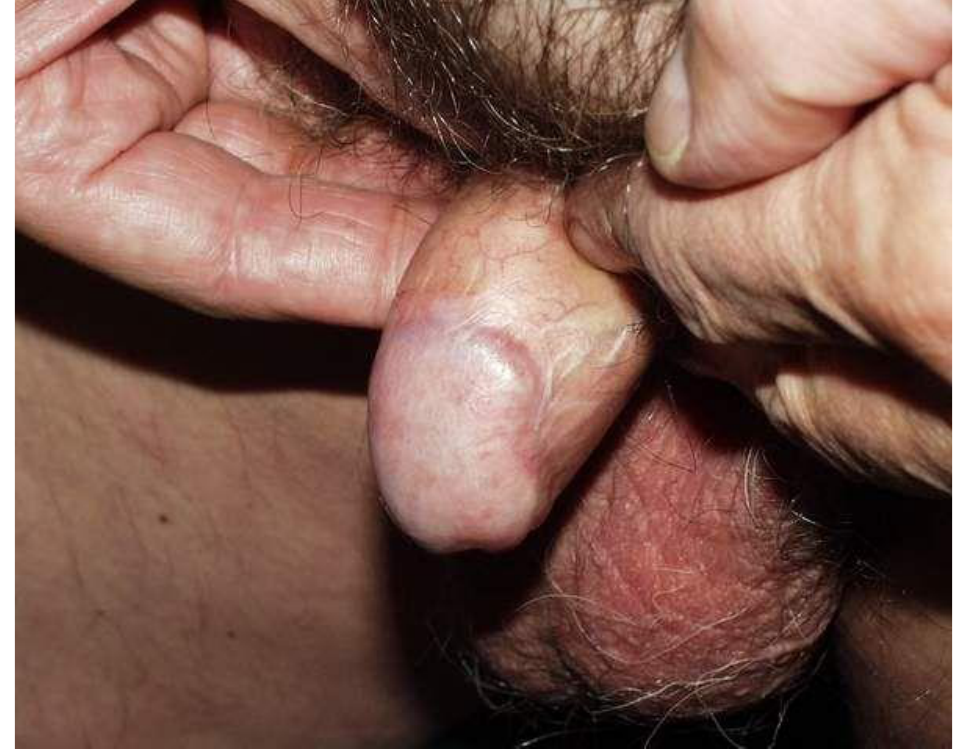
Figure 5. Result at 5 years.